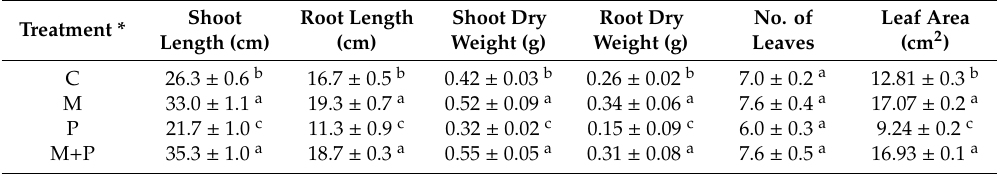
Table 2. Growth parameters of sunflower plants in response to colonization with R. irregularis and / or infection with R. solani (28 days after inoculation with R. solani ).